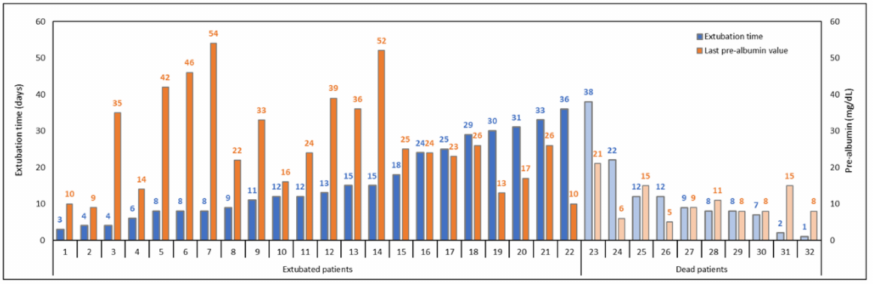
Figure 4. Extubation time and pre-albumin value of survivors and non-survivors during the days of ICU stay: Patients are represented in ascending order of extubation time (for survivors) and in descending order of survival time (for non-survivors). For each patient the last pre-albumin value available before the event (extubation or exitus) is represented. A decreasing trend is observed in pre-albumin level of extubated patients (high levels of pre-albumin—reduced extubation time), while for deceased patients the trend is more